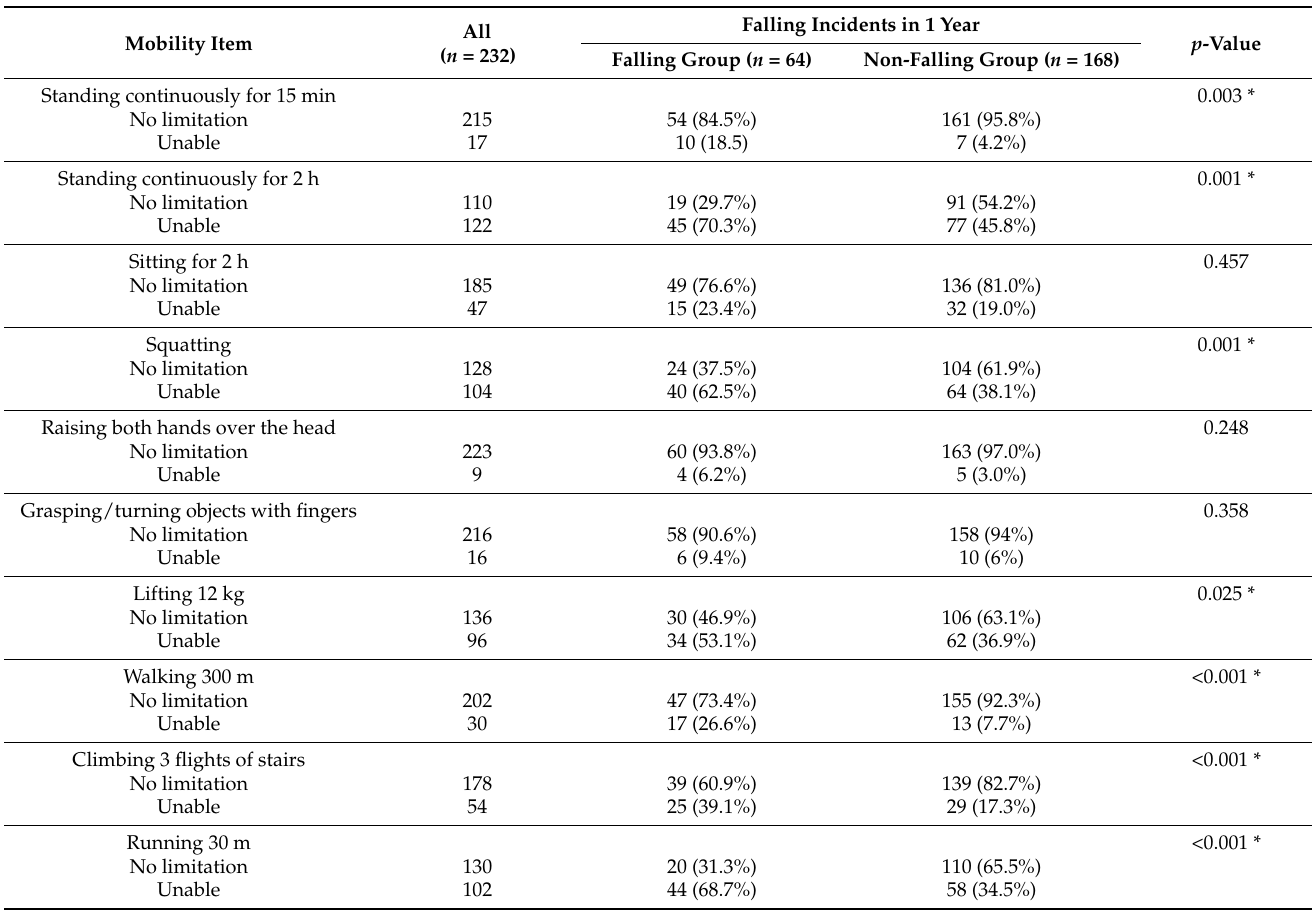
Table 2. Differences in participants’ answers to mobility limitation questions associated with